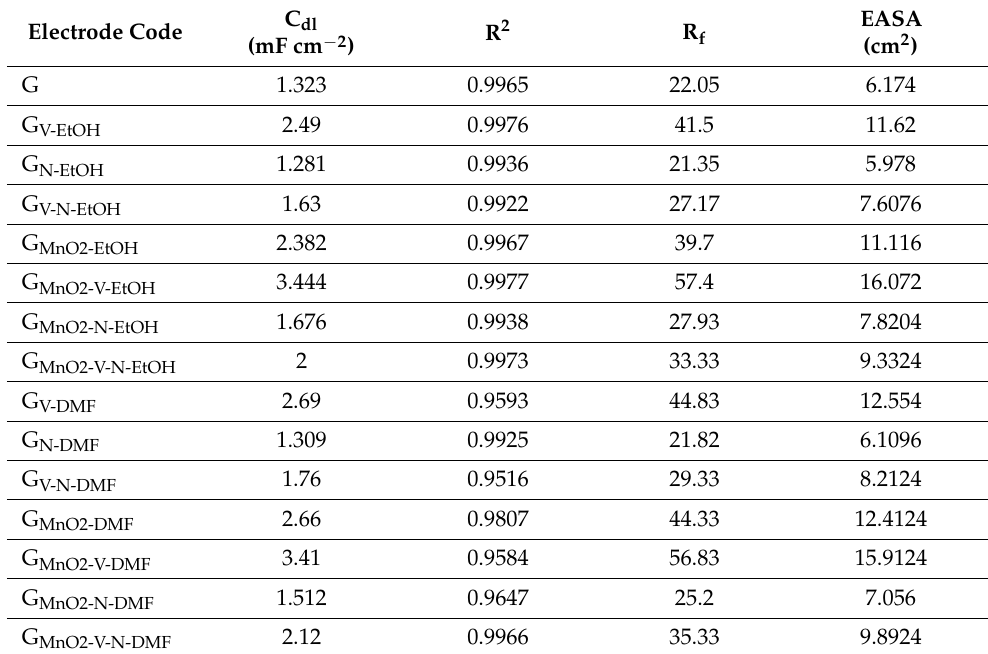
Figure 9. ( a ) The plot of the dependence between i dl and v for the bare electrode and for the electrodes modified using suspensions in ethanol. ( b ) The plot of the dependence between i dl and v for the electrodes modified using suspensions in DMF. Table 3. The C dl , R 2 , R f , and EASA values obtained for the bare and modified electrodes.